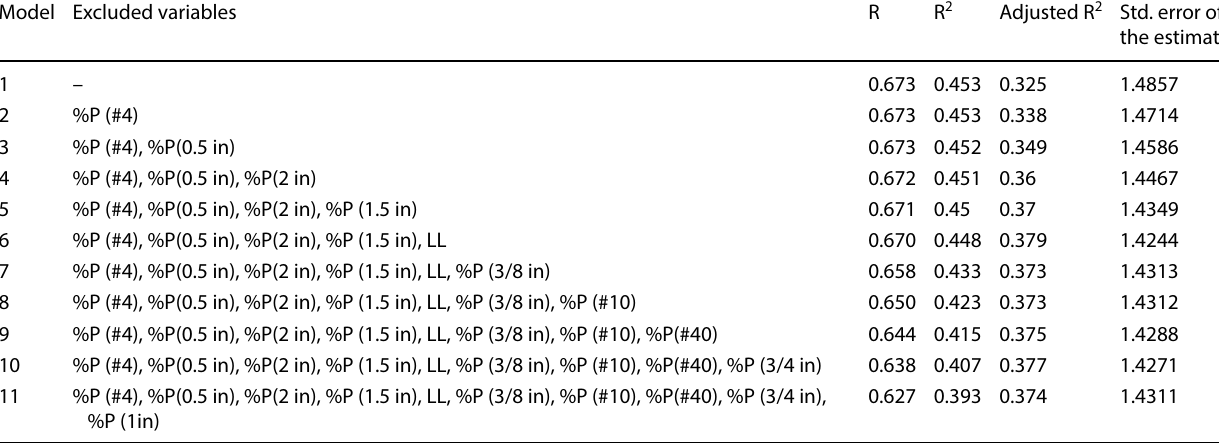
Table 8 Steps of the backward elimination process for developing the OMC MLR model